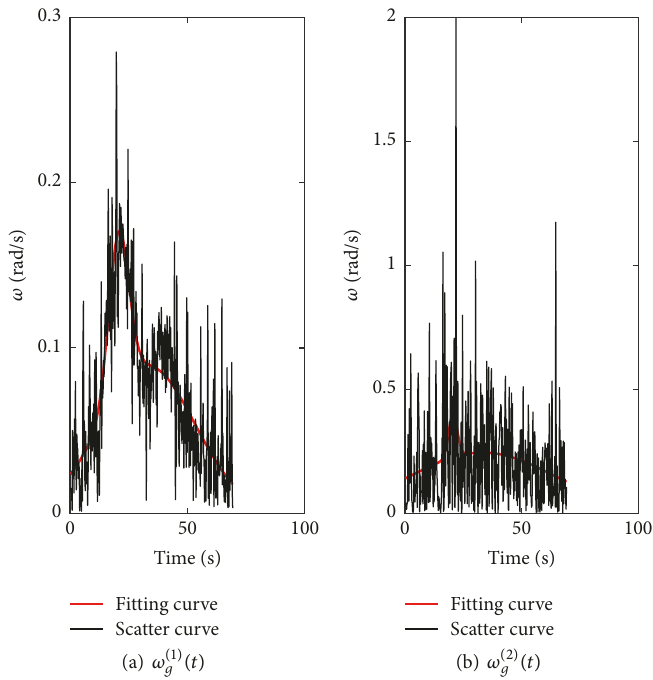
Figure 6: Fitting of parameters 𝜔 (1) 𝑔 (𝑡),𝜔 (2) 𝑔 (𝑡) for the Chi-Chi accelerogram seismic